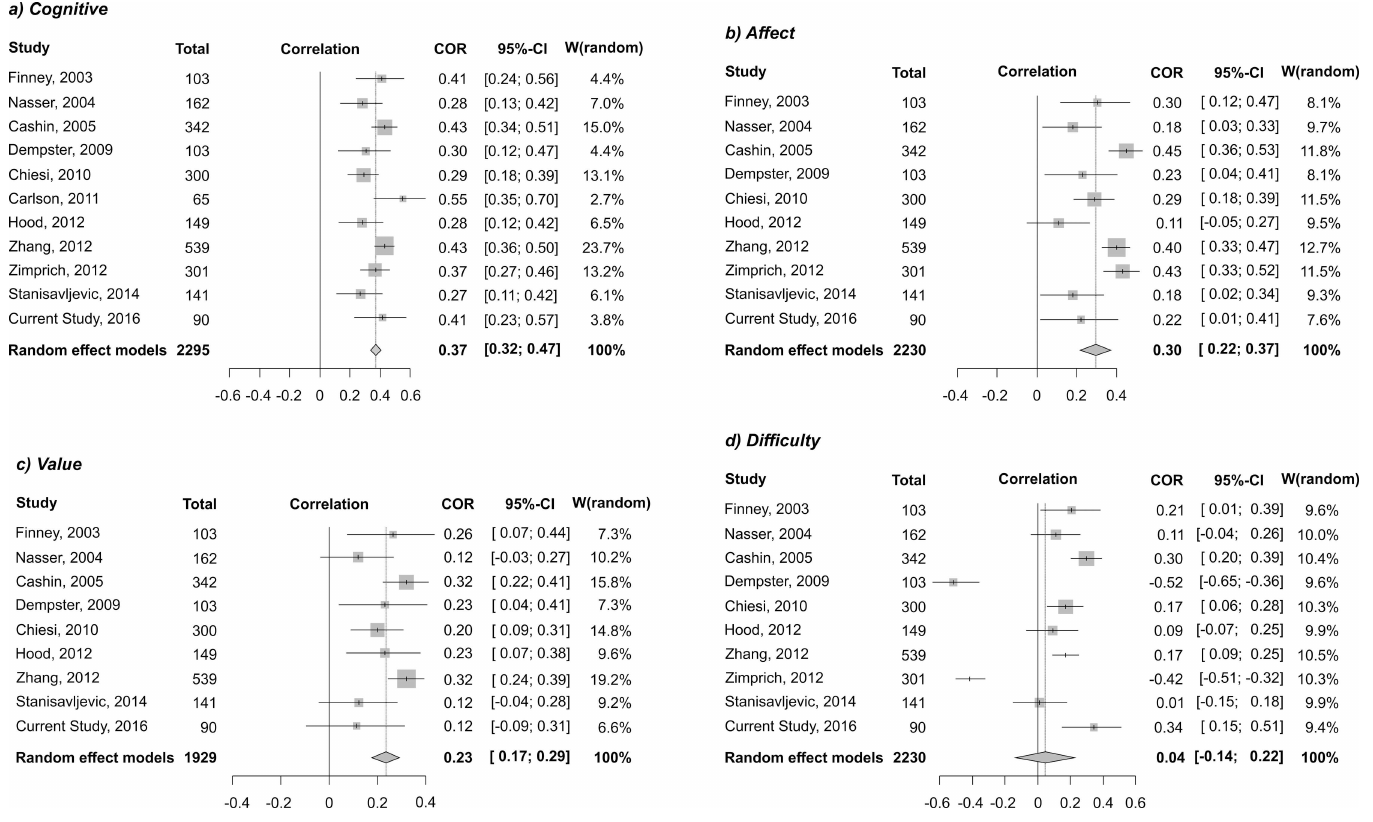
Fig 2. Forest plots for correlationcoefficients (back transformed, z to r) between SATS componentsand statistics achievement a) Cognitive, b) Affect, c) Value and d) Difficulty